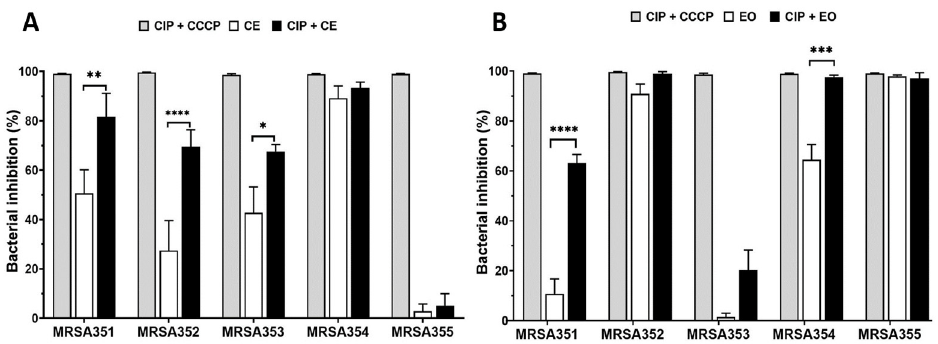
Figure 4. The potential effects of nutmeg crude extract (CE) and essential oil (EO) with CIP against five MRSA strains. The effects of CCCP, CE, and CE with CIP combination ( A ), and CCCP, EO, and EO with CIP combination ( B ) were determined by analyzing the percent inhibition of bacterial growth (colony counting method). *: p < 0.05; **: p < 0.01; ***: p < 0.001; **** p < 0.0001.